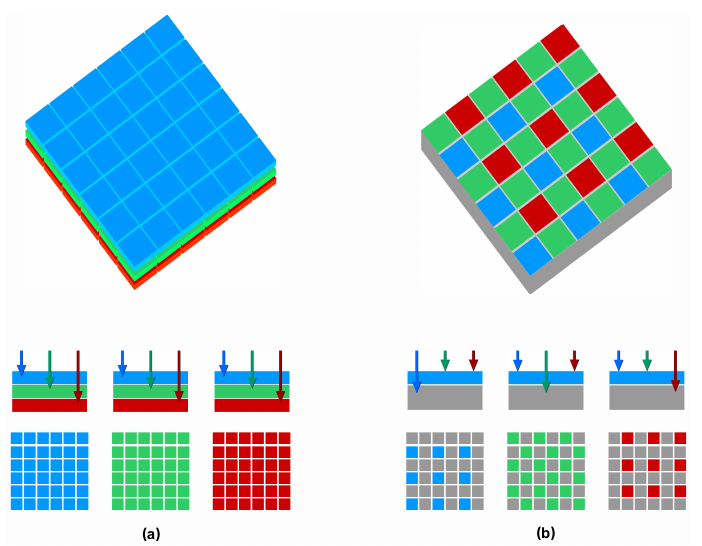
Figure 2. Filter patterns for the spectral information acquisition. ( a ) Foveon-based sensor. ( b ) Bayer filter